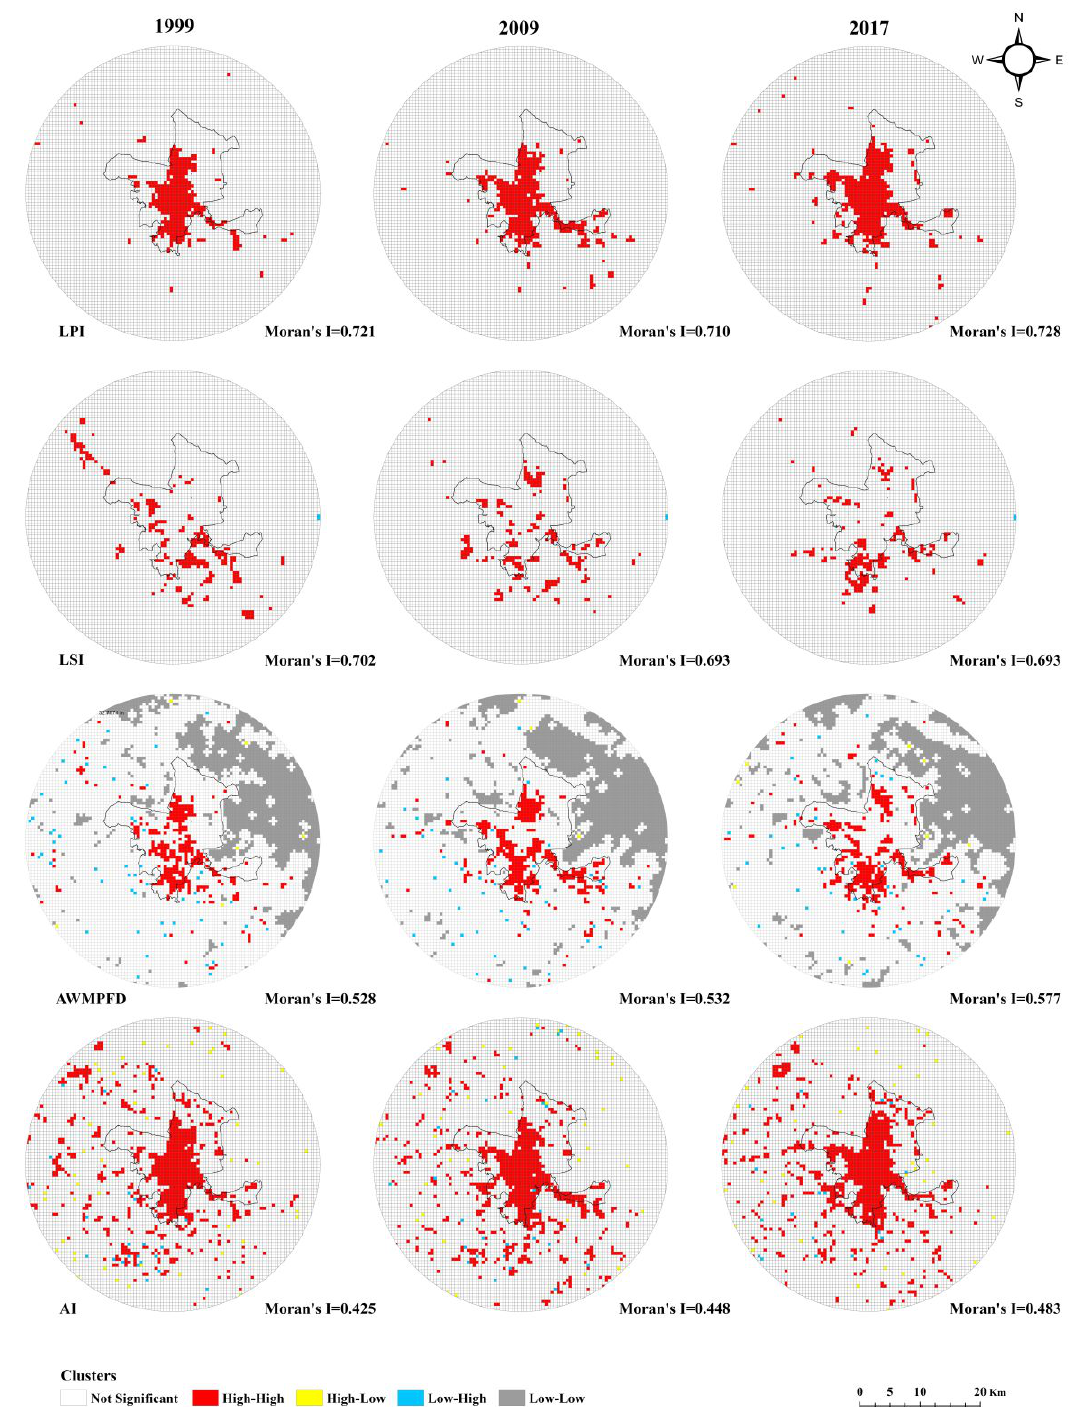
Figure 13. Spatial clusters of landscape metrics at 500 m cell-size in 1999, 2009 and 2017 identified through local indicators of spatial association (LISA) along with their global Moran’s I